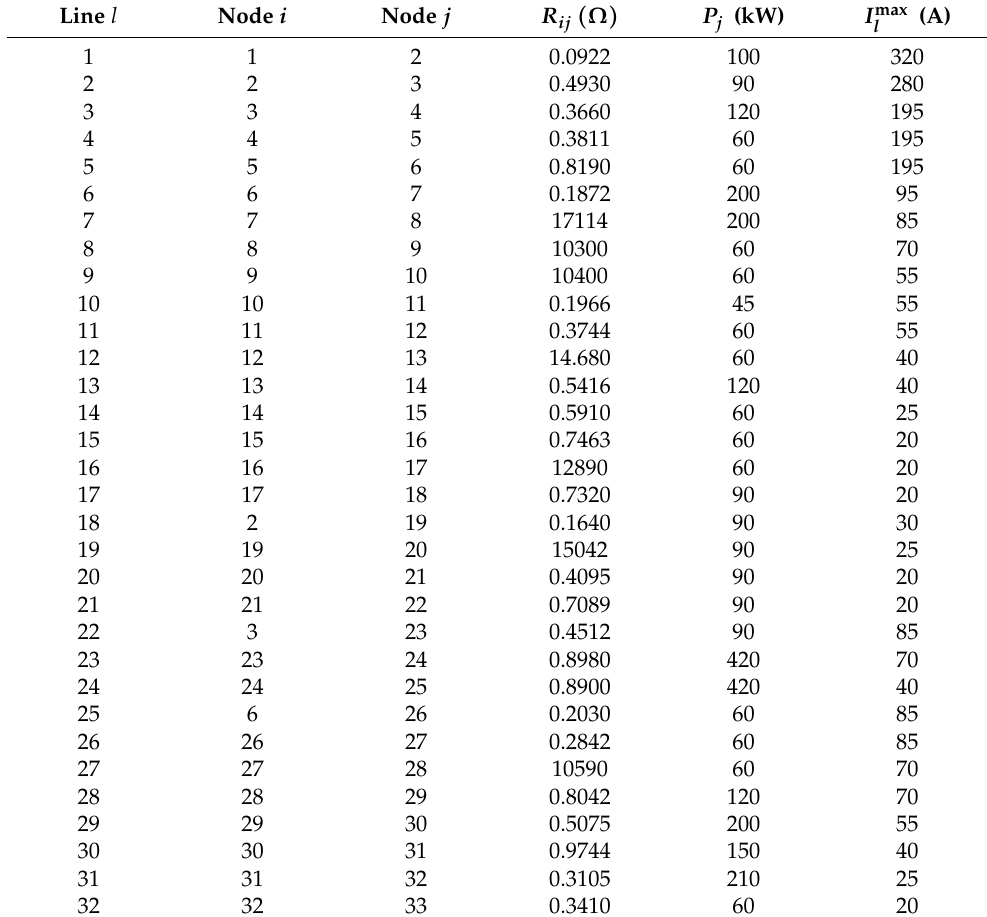
Figure 3. Electrical configuration of the grid-connected DC network. Finally, to evaluate the effect of PV generation in the grid-connected system, three PV sources with nominal rates of 2400 kW were added to nodes 12, 15 and 31, respectively. Table 2. Parametric information of the grid-connected network.